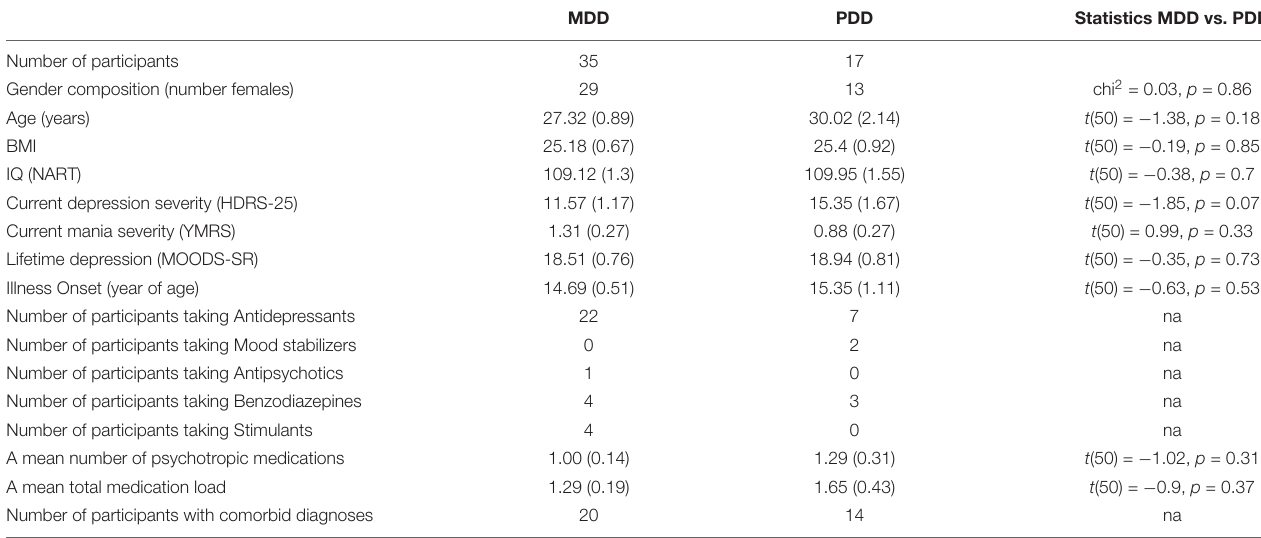
TABLE 2 | Demographic and clinical characteristics of individuals diagnosed with major depressive (MDD) and persistent depressive (PDD) disorders. MDD PDD Statistics MDD vs.